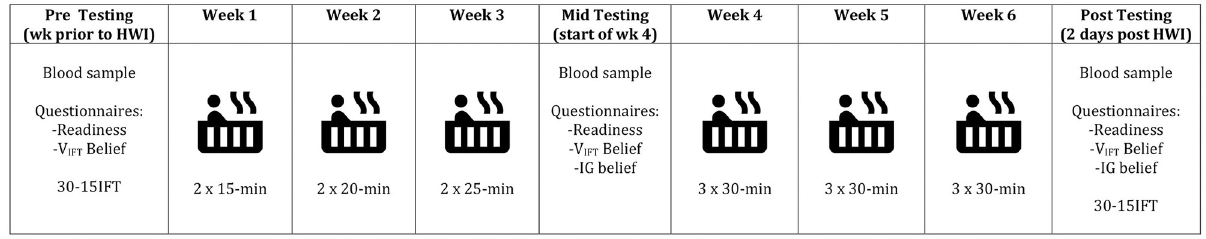
Fig 1. Outline of hot water immersion intervention. 30-15 IFT : 30–15 Intermittent Fitness Test. V IFT belief: Intermittent running performance belief. IG belief: in-game running ability belief.